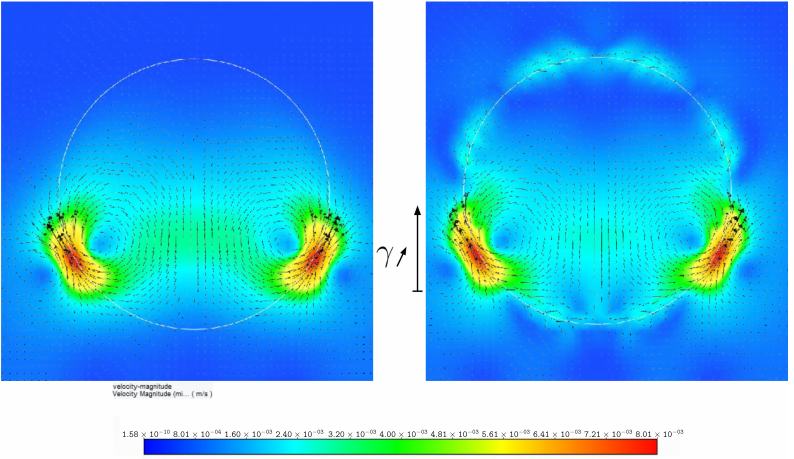
Figure 3. Example of a simulation, with a Marangoni current generated along with the interface of a bubble from a gradient of surface